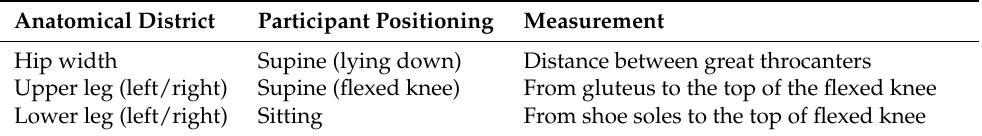
Table 1. Anthropometric measurements needed to customize the EKSO to the participant body. Anatomical